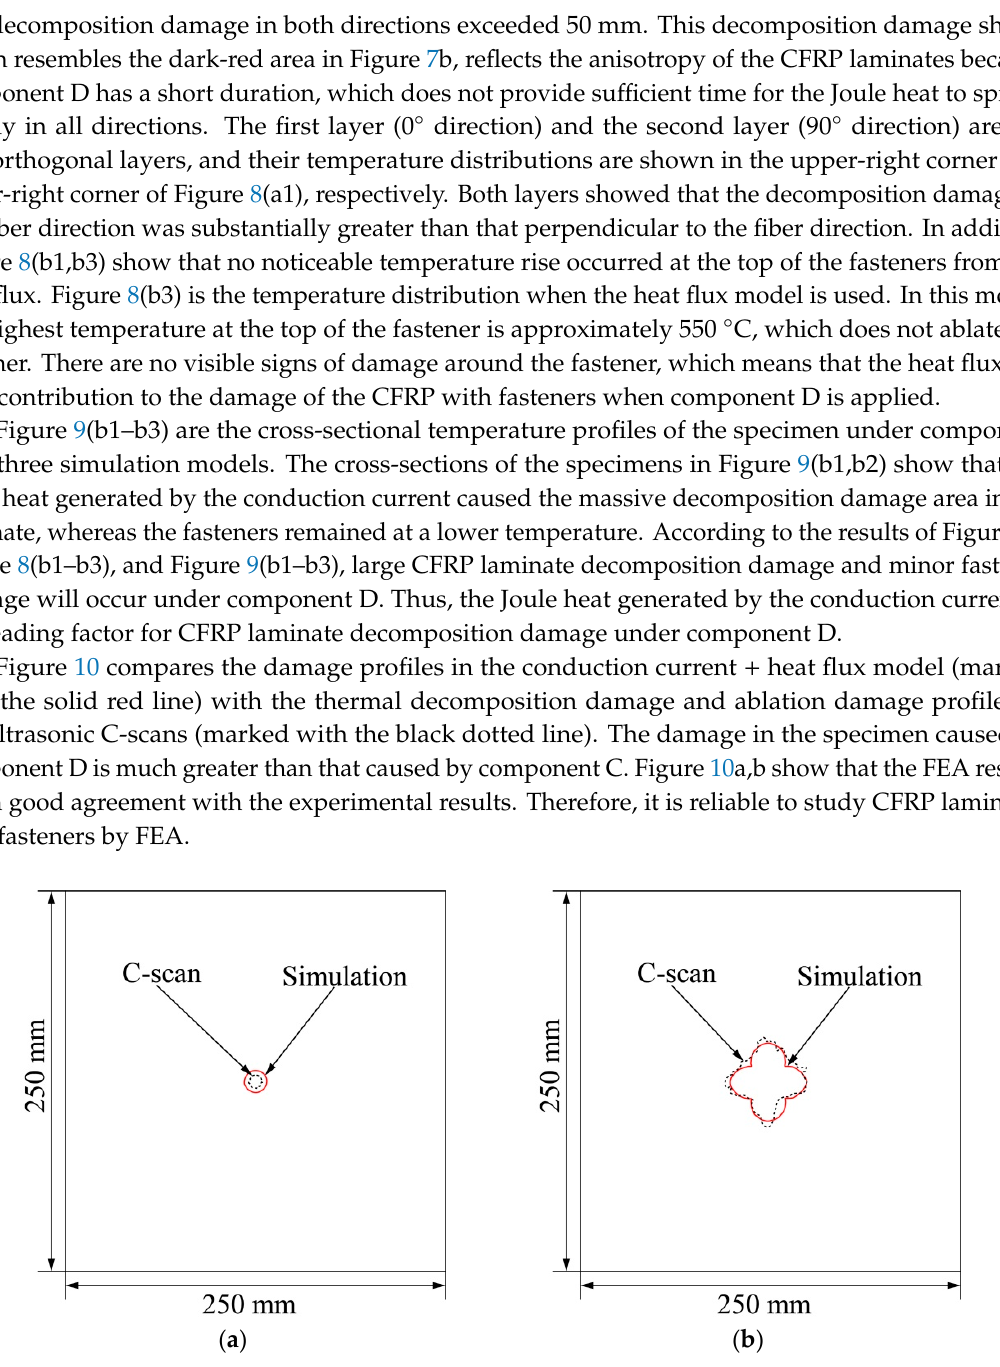
Figure 10. Damage comparison between simulated lightning strikes and finite element simulations: ( a ) component C; ( b ) component D.